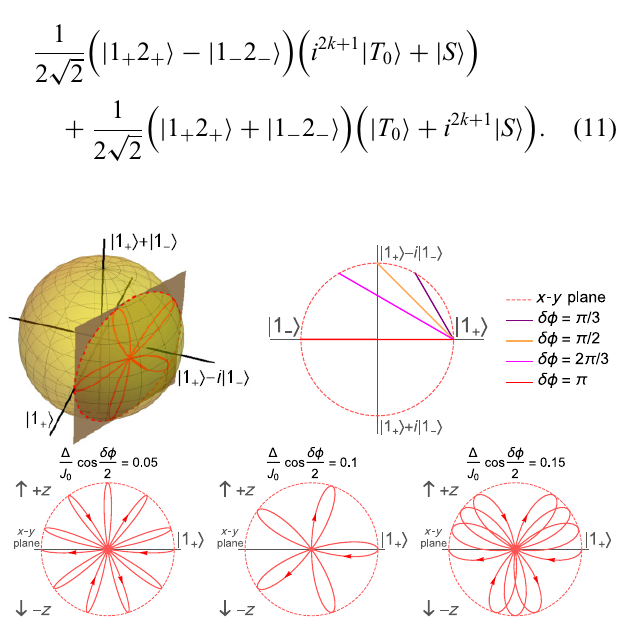
FIG. 3. Top left: the Bloch-sphere representation of the time evolution of the valley state of dot 1 in Eq. (10). The path forms a rose curve that lies within the plane given by x + y tan δφ = 1. Top right: the projection of this path into the x - y plane, plotted for different values of δφ . The plot for the valley state of dot 2 is identical but reflected vertically. Bottom: sample rose curves plotted for values of the quantity (cid:2) cos (δφ/ 2 )/ J 0 equal to 0.05, 0.1, and 0.15. The horizontal axis is the chord plotted in the top right figure, and the dashed circle is the intersection of the Bloch sphere with the plane x + y tan δφ =